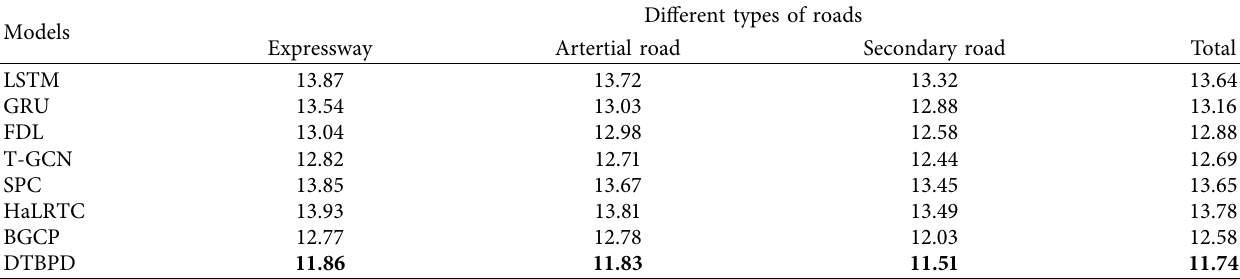
Table 2: The overall performance of different models in terms of MAPE (%).